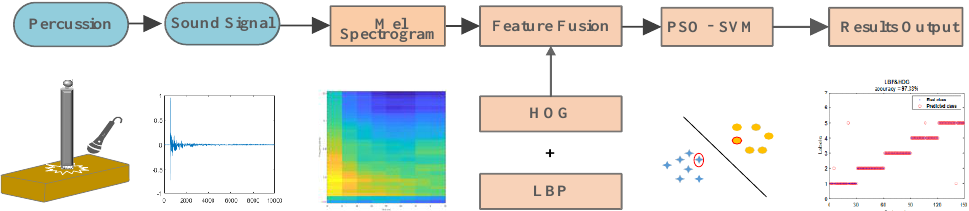
Figure 1. Schematic diagram of the proposed percussion method and PSO-SVM.